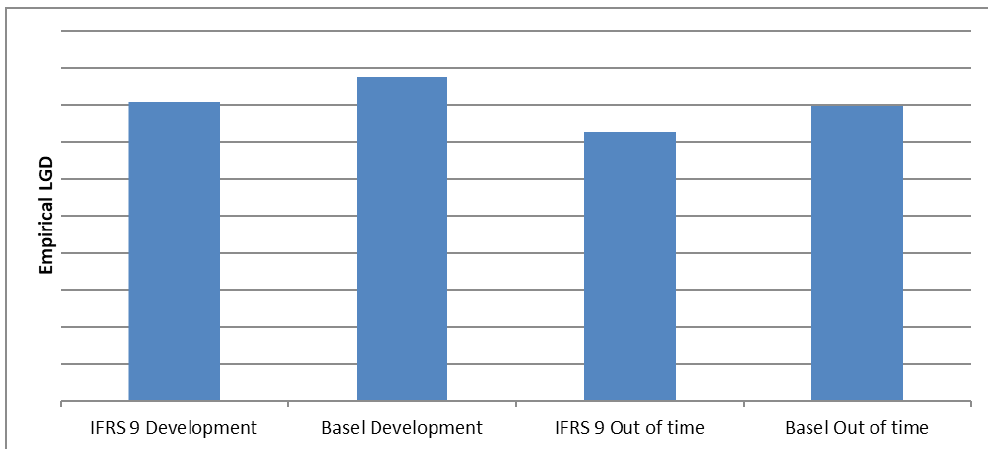
Figure 2. Empirical IFRS 9 and Basel LGDs for the development period and out of